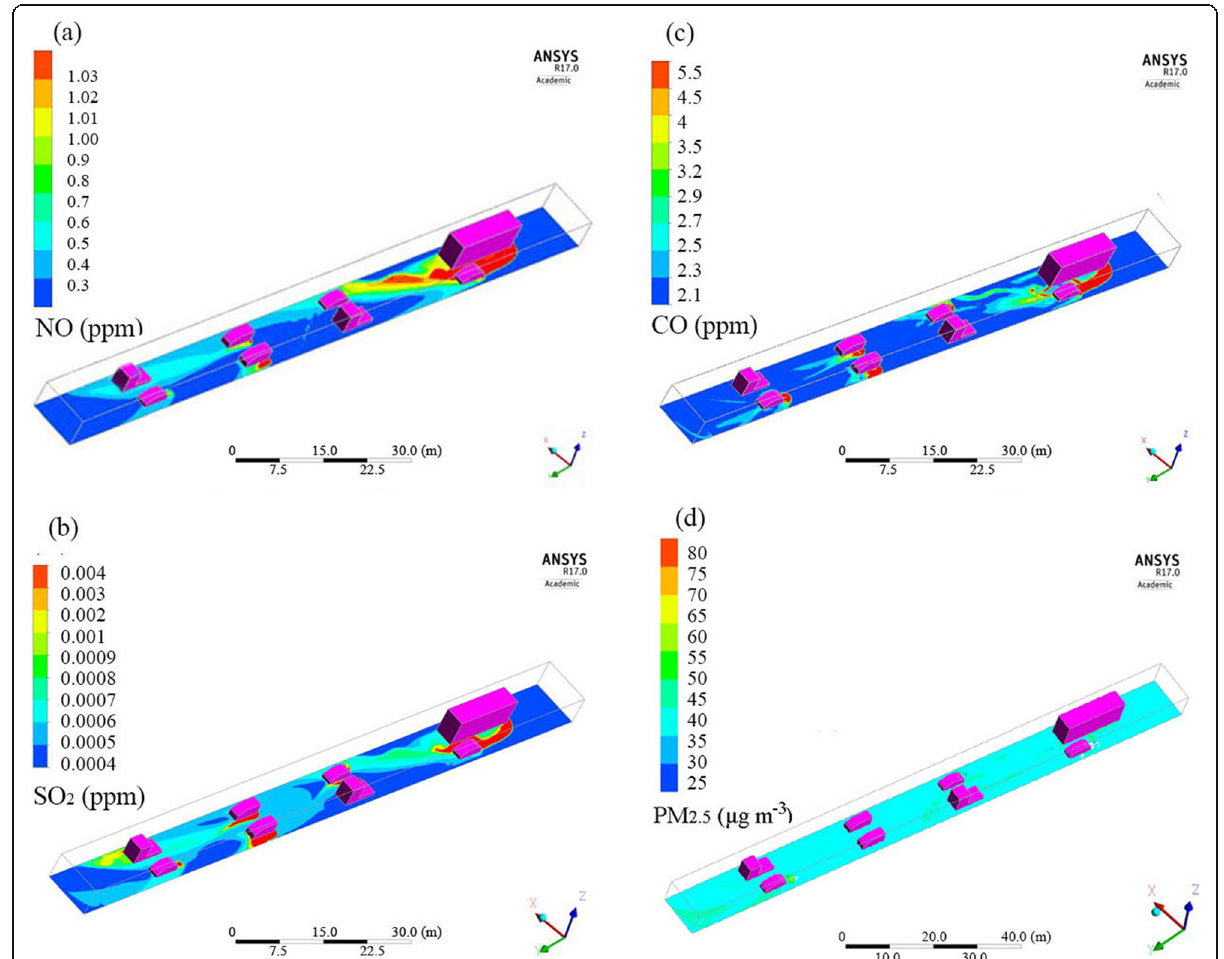
Fig. 6 a NO concentrations (ppm) on weekdays; b SO 2 concentrations (ppm) on weekdays; c CO concentrations (ppm) on weekdays; d PM 2.5 concentrations ( μ g m − 3 ) on